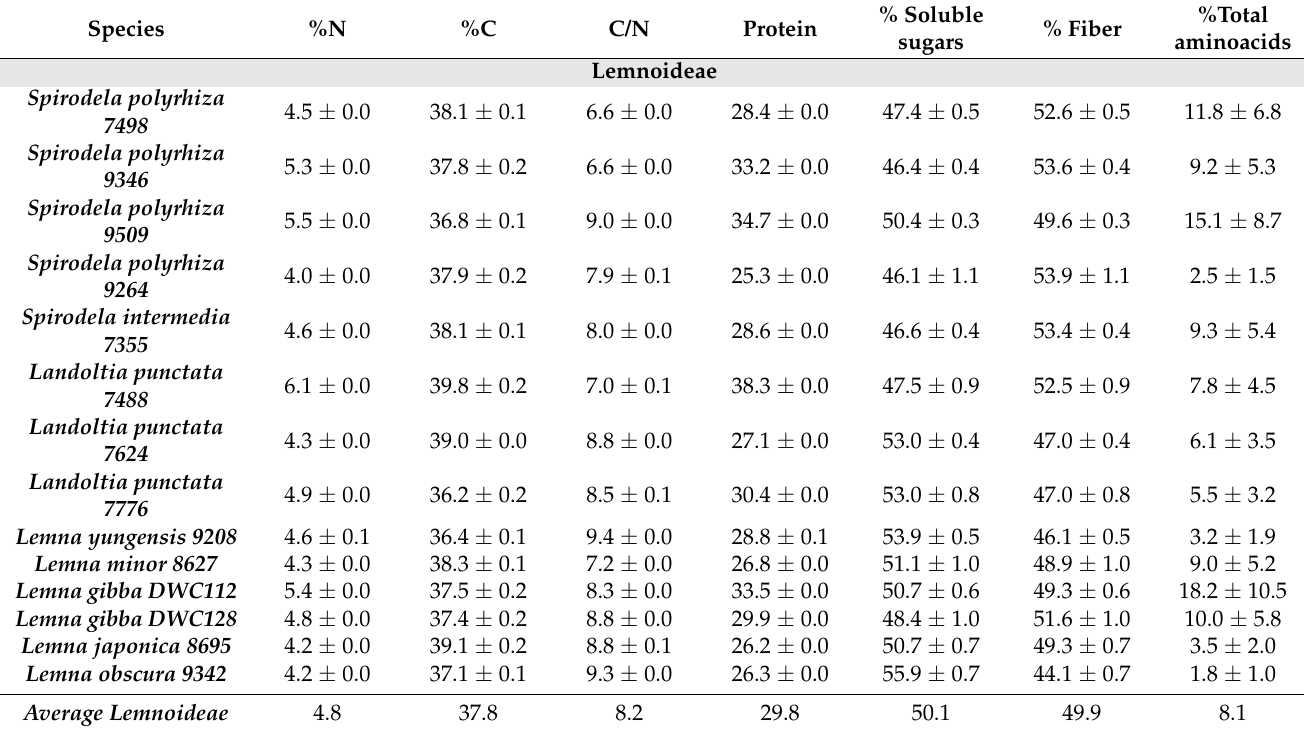
Table 1. General contents of carbon, nitrogen, protein, soluble sugar, and fiber in 21 ecotypes of duckweeds. Data represented by the mean ± standard error ( n =